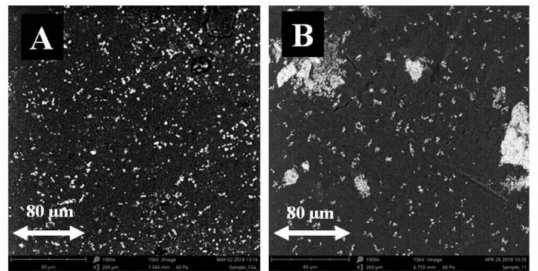
Figure 3. Microstructure of PLA and Fe 3 O 4 composite polymerized without CMF ( A ) and under the exposure to CMF with magnetic induction B = 0.5 T ( B ), magnification 1000 × .